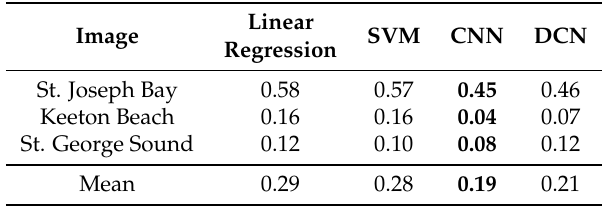
Table 2. RMSEs obtained by three -fold CV in the selected regions. Best results are highlighted in